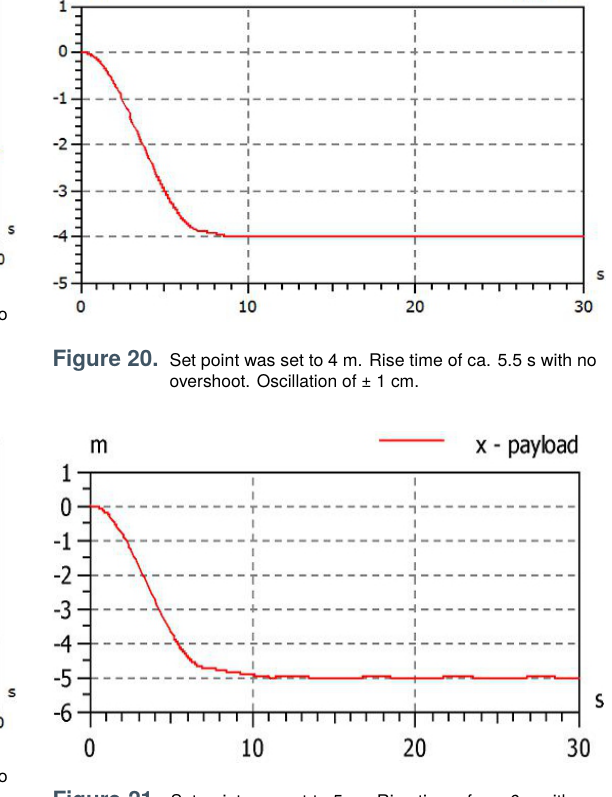
Figure 21. Set point was set to 5 m. Rise time of ca. 6 s with no overshoot. Oscillation of ± 1